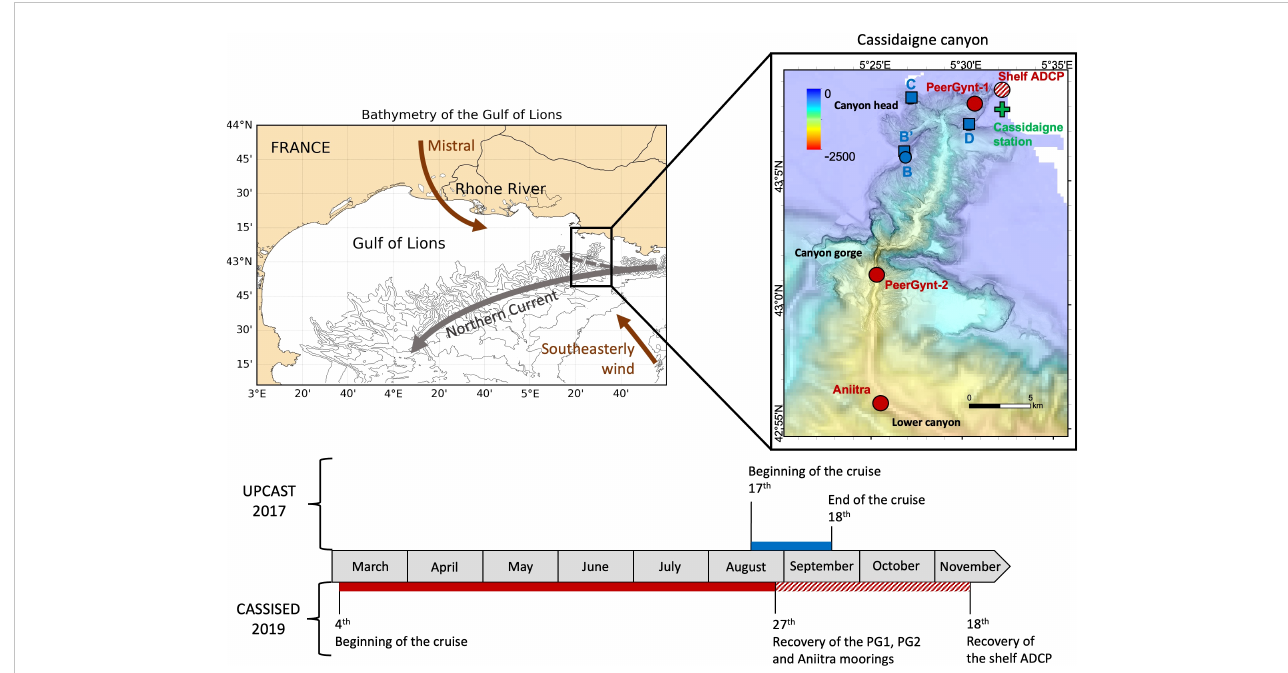
FIGURE 1 Bathymetry of the Gulf of Lions (top left), located between 42°N and 43.5°N of latitude and between 3°E and 6°E of longitude in the Mediterranean Sea, a semi-enclosed microtidal sea linked with the Atlantic Ocean by the Strait of Gibraltar. Its depth varies from 76 m on average on the shelf to 2500 m in the open sea. The gray arrow corresponds to the general circulation of the NC and the dashed gray arrow refers to its intrusion over the Gulf of Lions. Bathymetry of the Cassidaigne submarine canyon (m, right), the easternmost canyon in the Gulf of Lions, located 7 km away from the coast of Cassis. The squares refer to the position of the Mastodon-2d thermistor lines and the circles correspond to the ADCP current moorings for both UPCAST 2017 (in blue) and CASSISED 2019 (in red) cruises. Their deployment time is speci fi ed on the time lines (bottom). The green cross refers to the T-MedNet Cassidaigne